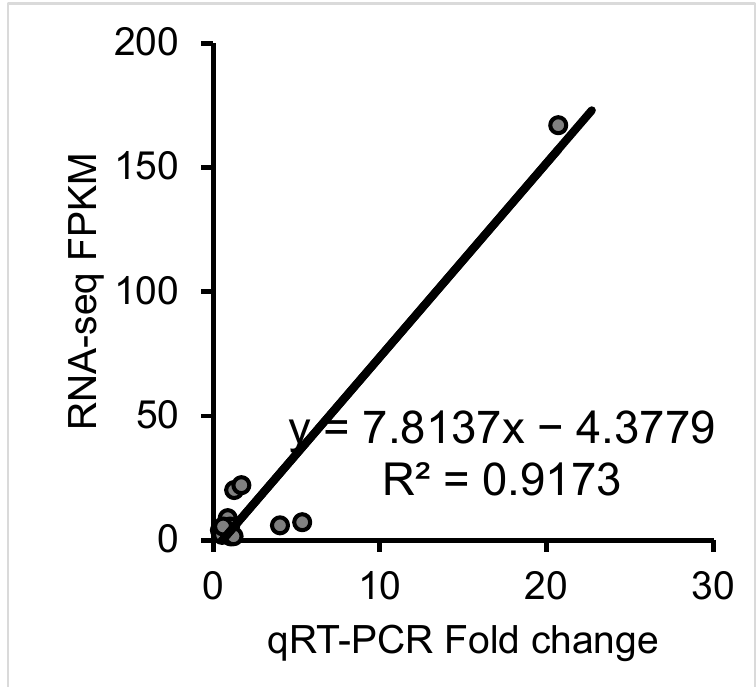
Figure 3. Quantitative real-time PCR (qRT-PCR) confirmation. Correlation analysis between RNA- seq and qRT-PCR methods; Log2(foldchange) values of RNA-seq data ( y -axis) are plotted against Log2(foldchange) values of qRT-PCR ( x -axis) data.